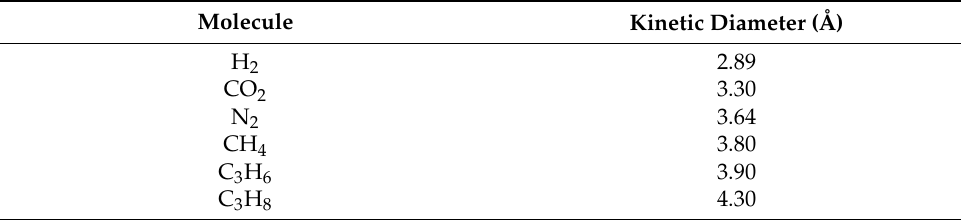
Table 3. Kinetic diameter for various